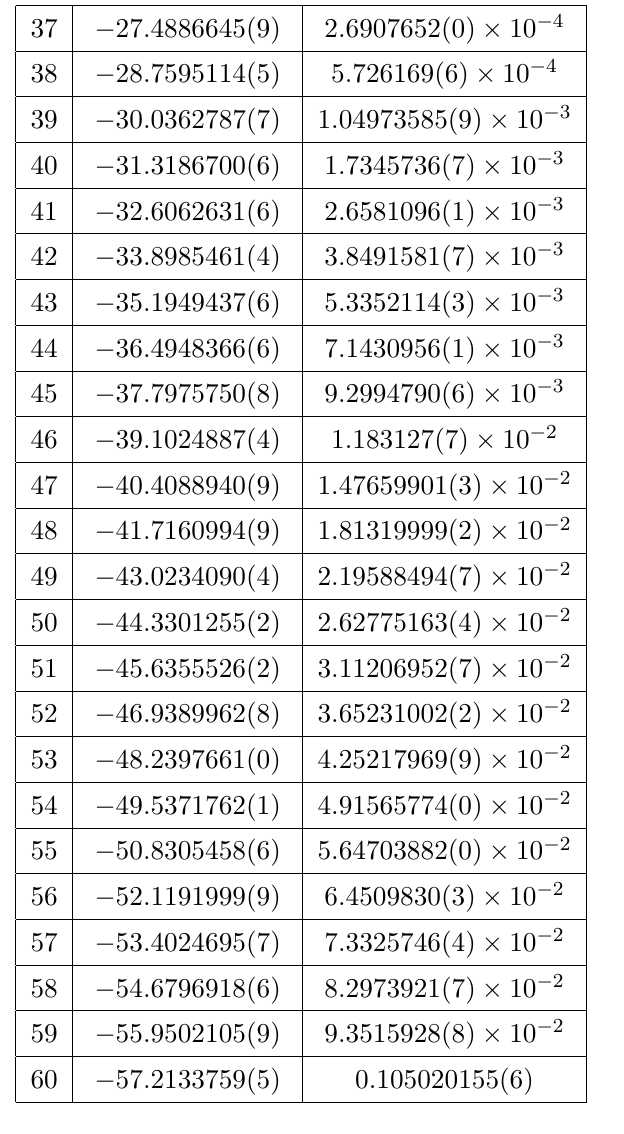
Table 3. Large N , partial phase, θ = 0